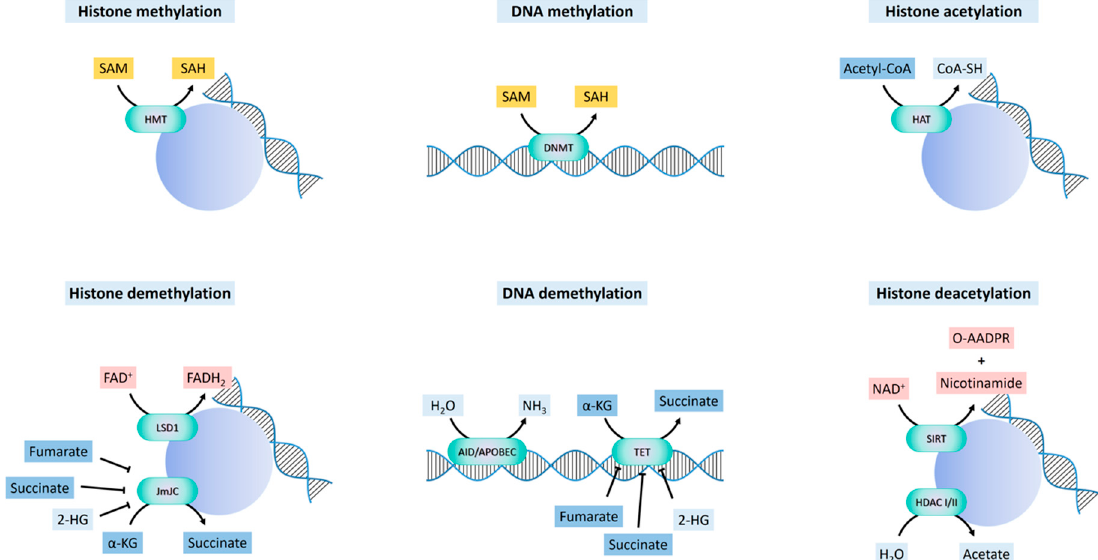
Figure 2. Mechanisms of histone and DNA methylation/demethylation and histone acetylation/deacetylation. S-adenosyl-methionine (SAM) acts as a methyl donor for histone and